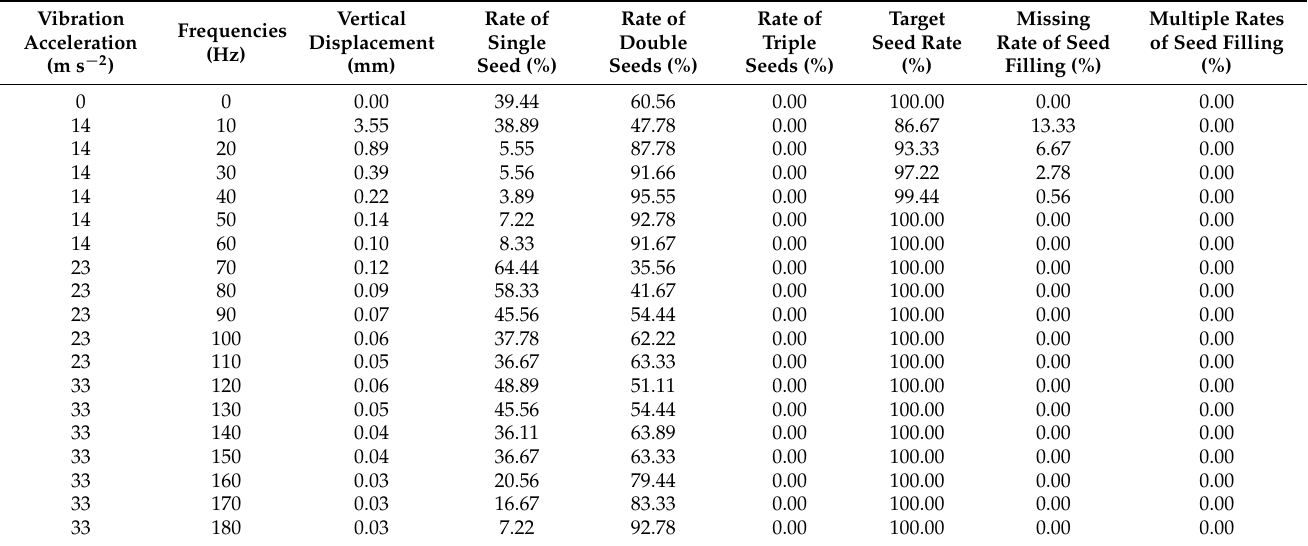
Table 5. Effect of vibration on seeding performance of seed-metering